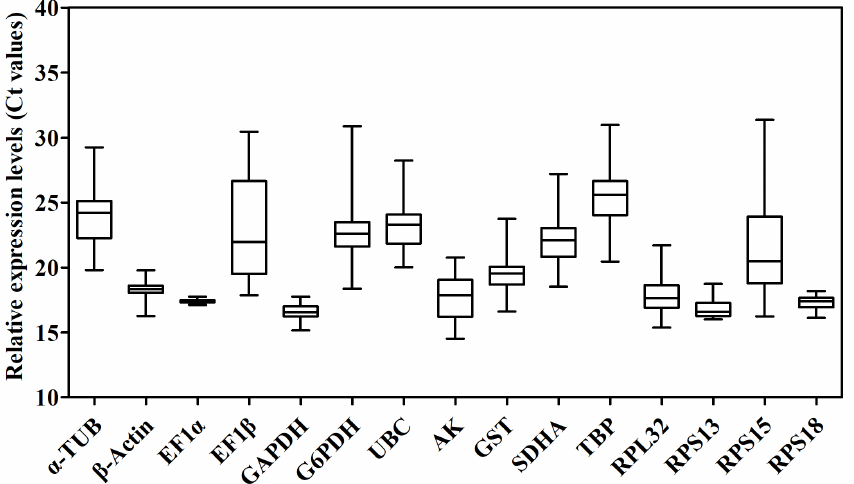
Figure 3. Candidate reference genes expression profiles in N. asiatica . The expression data are presented as mean Ct values of candidate reference genes across all samples under eight different experimental conditions. Whiskers represent the maximum and minimum values. The lower and upper borders of the boxes represent the 25th and 75th percentiles, respectively. The line across the box indicates the median Ct value.